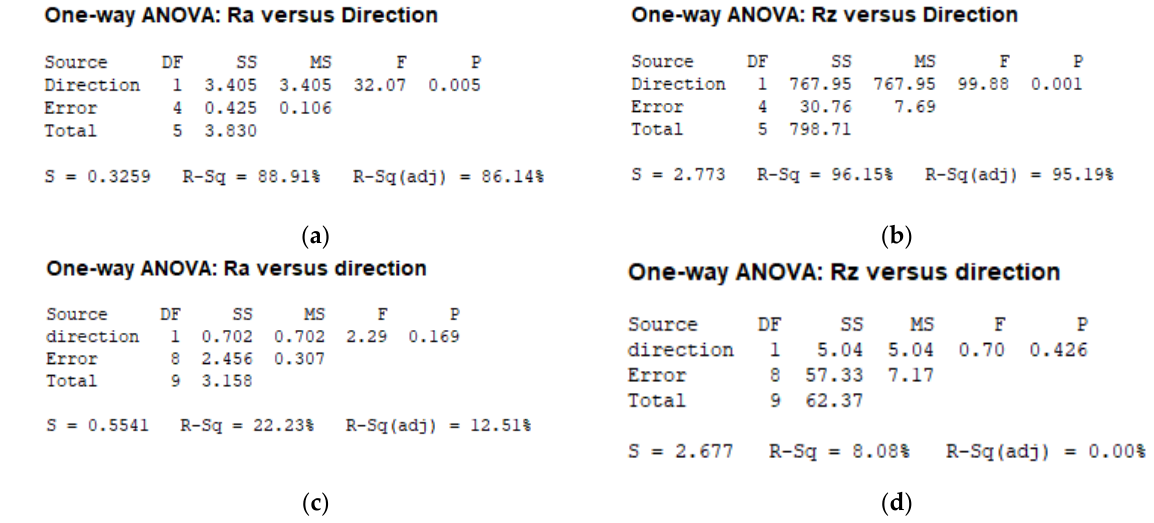
Figure 3. AnoVA analysis of x and y directions vs. the initial average surface roughness (Ra) and average peak-to-valley height (Rz) for as-sprayed ( a , b ) and after shot peening ( c , d ) HVOF-treated samples. Table 3. Ra and Rz values after HVOF coating with and without shot peening.